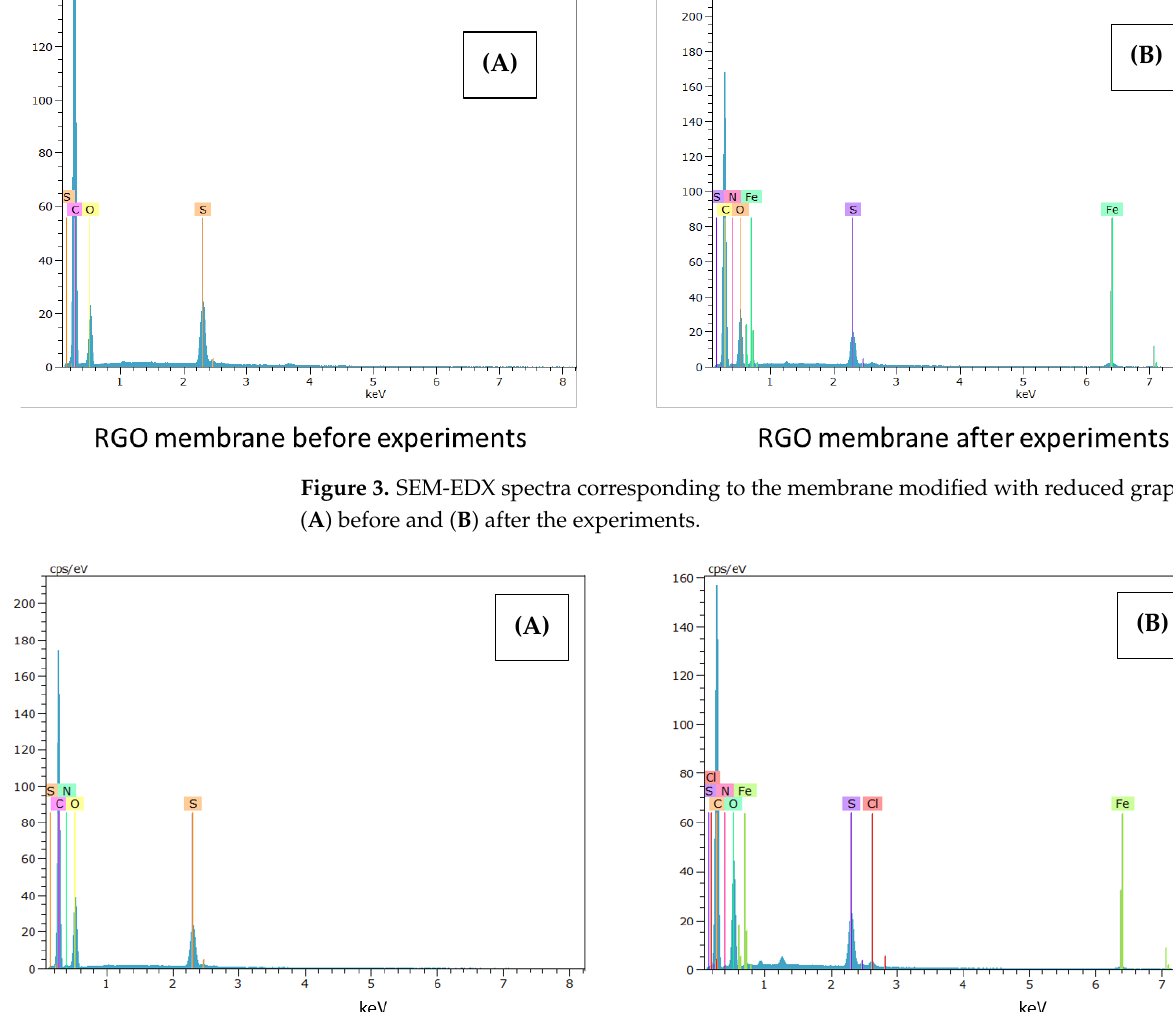
Figure 2. SEM-EDX spectra obtained with ( A ) the native membrane before and ( B ) after the experi- ments.